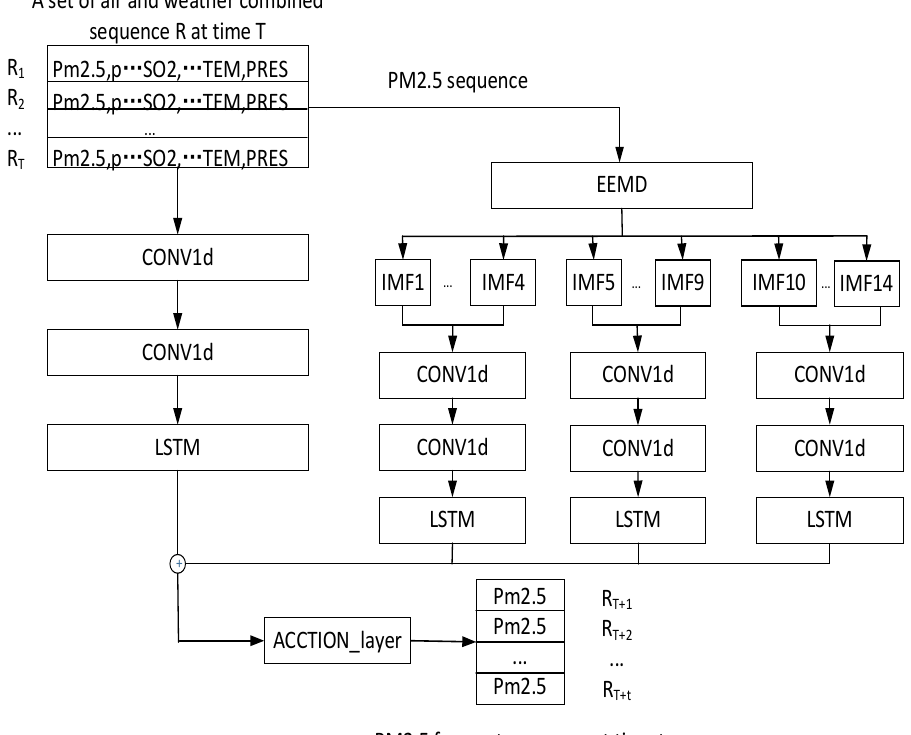
Figure 2. System flow of multi-time scale network model.